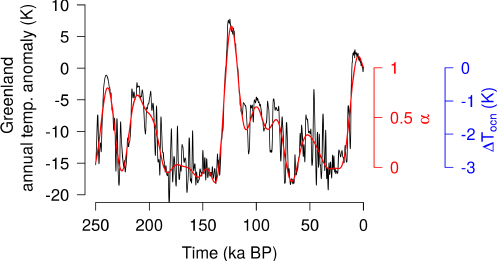
Figure 1. The 250ka Greenland annual temperature anomaly signal built through a multiproxy approach based on the reconstruction by Vinther et al. (2009) from 11.7kaBP to present, the NGRIP recon- struction (Kindler et al., 2014) for 115–11.7kaBP, the NEEM re- construction (NEEM, 2013) for 135–115kaBP and a synthetic tem- perature anomaly time series for 250–135ka BP following Barker et al. (2011) (black line). The red line shows the filtered and normal- ized climatic index α used to correct the present-day climatological fields when forcing the model. The same signal can be interpreted as the palaeo-oceanic temperature anomaly of Eq. (8) (in